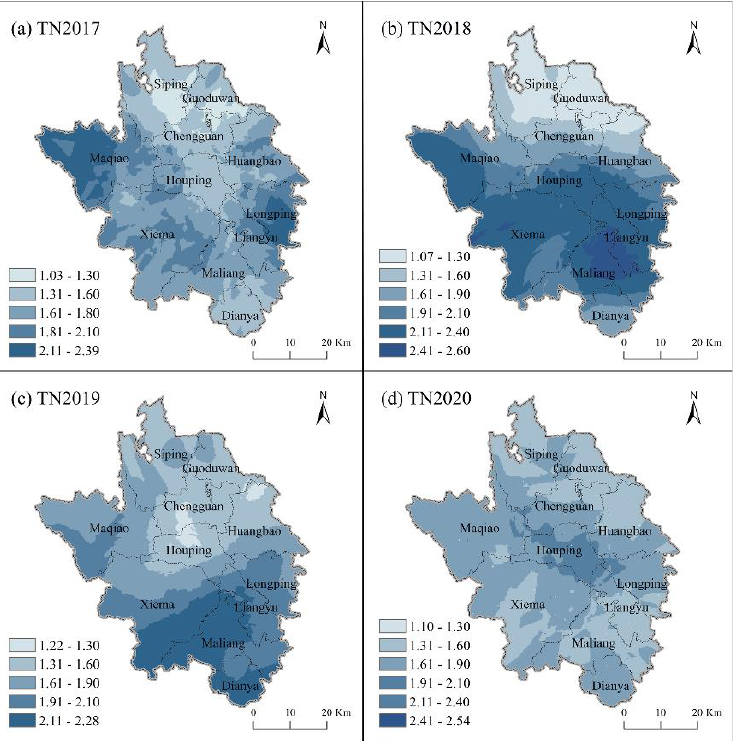
Figure 8. Ordinary kriging distribution maps for ( a ) 2017 TN, ( b ) 2018 TN, ( c ) 2019 TN and ( d ) 2020 TN.